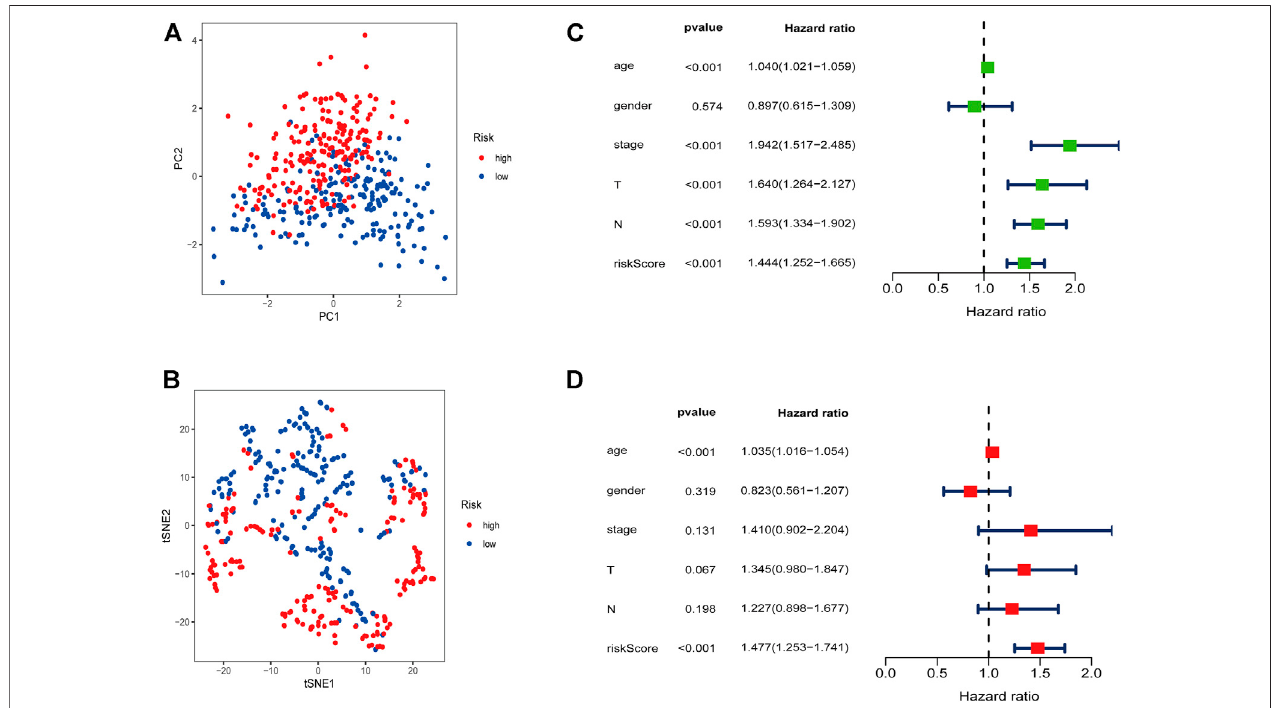
FIGURE5| Risksignaturewasanindependentpredictor ofprognosis. (A) PCA plotinthetworiskgroups. (B) t-SNEanalysisinthetworiskgroups.Univariate (C) and multivariate (D) Cox analysis.